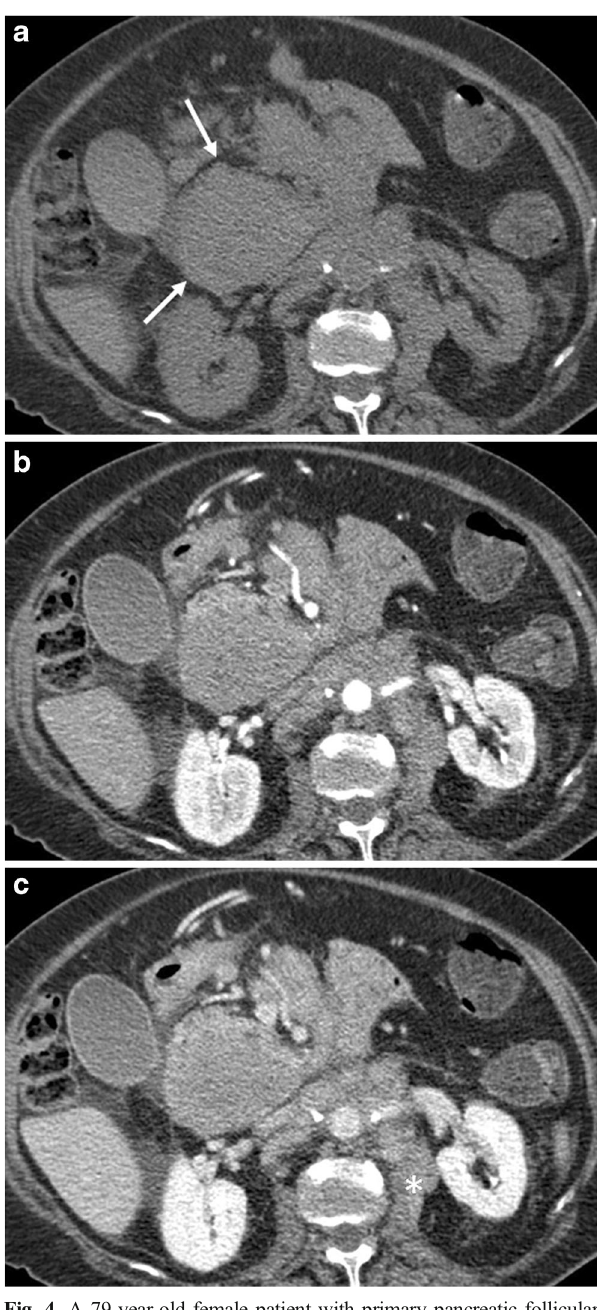
Fig. 4 A 79-year-old female patient with primary pancreatic follicular lymphoma (Ki 67 score < 25%). a Unenhanced CT scan depicts a hypodense mass in the pancreatic head (arrows). b, c CT images after contrast medium administration in the arterial-pancreatic ( b ) and portal- venous phase ( c ): progressive enhancement of the neoplasm is visible. Enlarged retroperitoneal lymph nodes with ill-defined margins are depicted